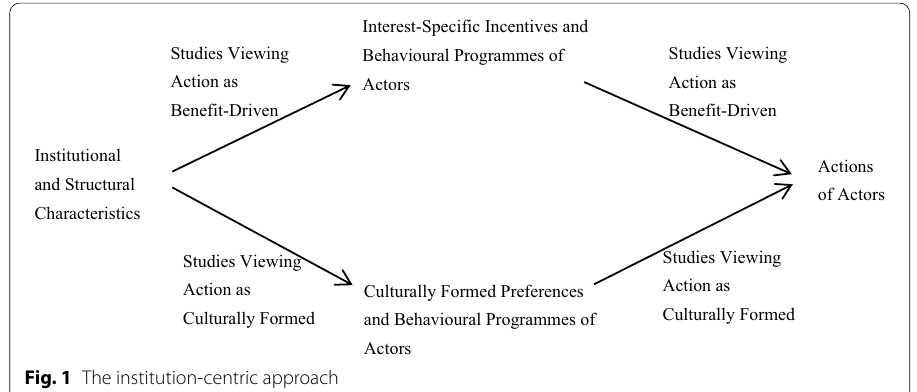
Fig. 1 The institution-centric